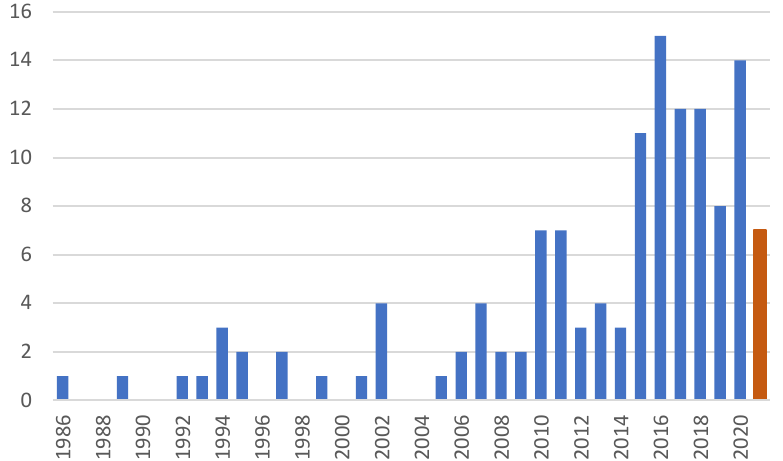
Figure 2. Number of publications on the application of BM in CD complex preparations till 28 July